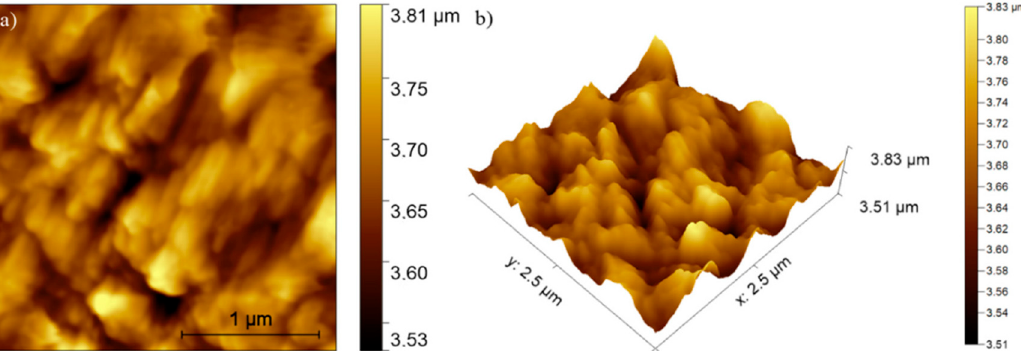
Figure 12. Atomic force microscopy (AFM) topography image of the 25MgHAp thin film surface presented in 2D ( a ) and 3D representation of the surface topography of 25MgHAp thin film ( b ).